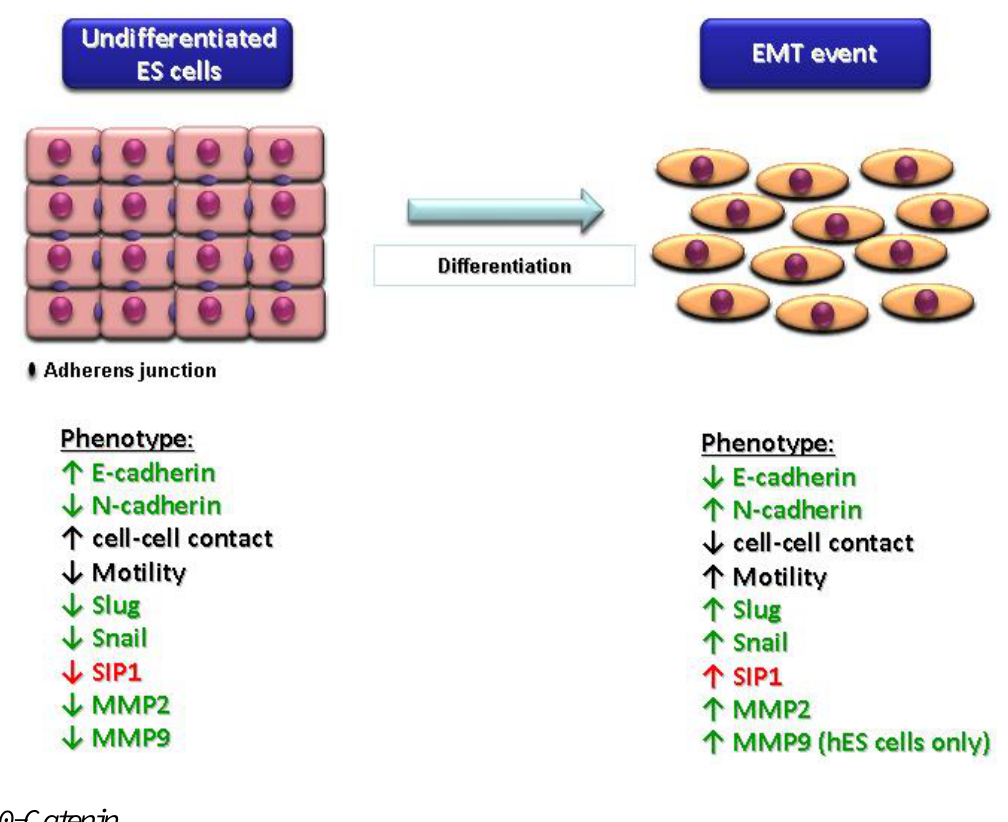
Figure 5. Diagrammatic representation of the transcriptional and translational events associated with epithelial-mesenchymal transition during mouse and human ES cell differentiation. Undifferentiated ES cells exhibit E-cadherin-mediated cell-cell contact and this is associated with low levels of N-cadherin, E-cadherin repressors (Slug, Snail and SIP1) and matrix metalloproteinases (MMPs) [112,113]. Upon induction of ES cell differentiation, E-cadherin protein is rapidly lost from the cell surface and this is associated with increased N-cadherin, E-cadherin repressor (Slug, Snail and SIP1) and MMP expression [112,113]. Green denotes changes in both transcripts and protein; red denotes changes in transcripts